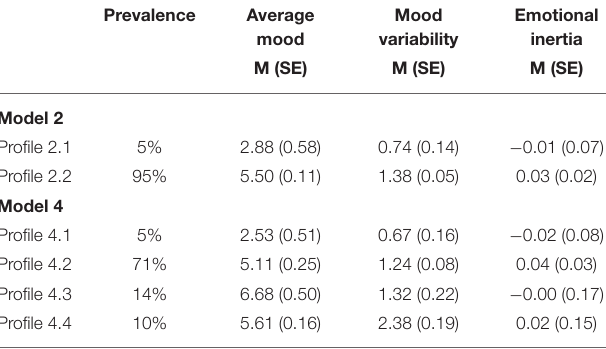
TABLE 2 | Standardized mean scores for each of the indicators in the two- and four-profile models.